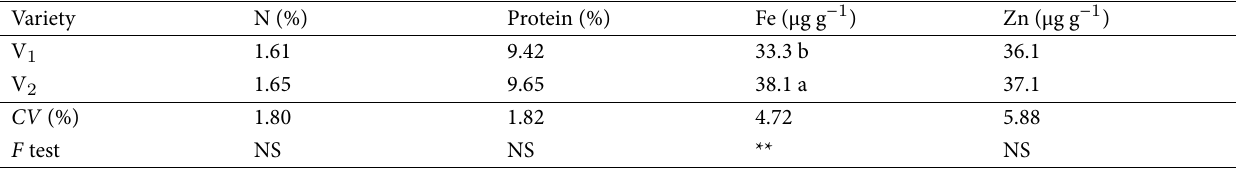
Table 8 Nitrogen, protein, Zn, and Fe concentrations of wheat grains influenced by